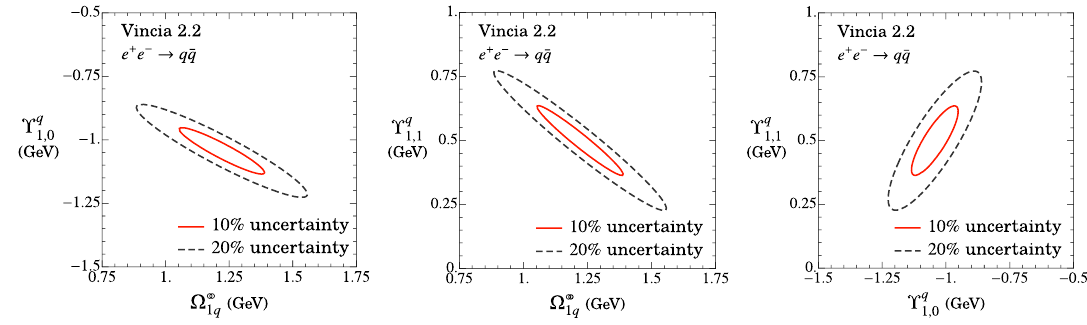
Figure 21 . 70% Con(cid:12)dence interval ellipses showing correlations between the hadronic parameters from Vincia when assigning 10% and 20% hadronization uncertainties. Other Monte Carlos yield ellipses of similar